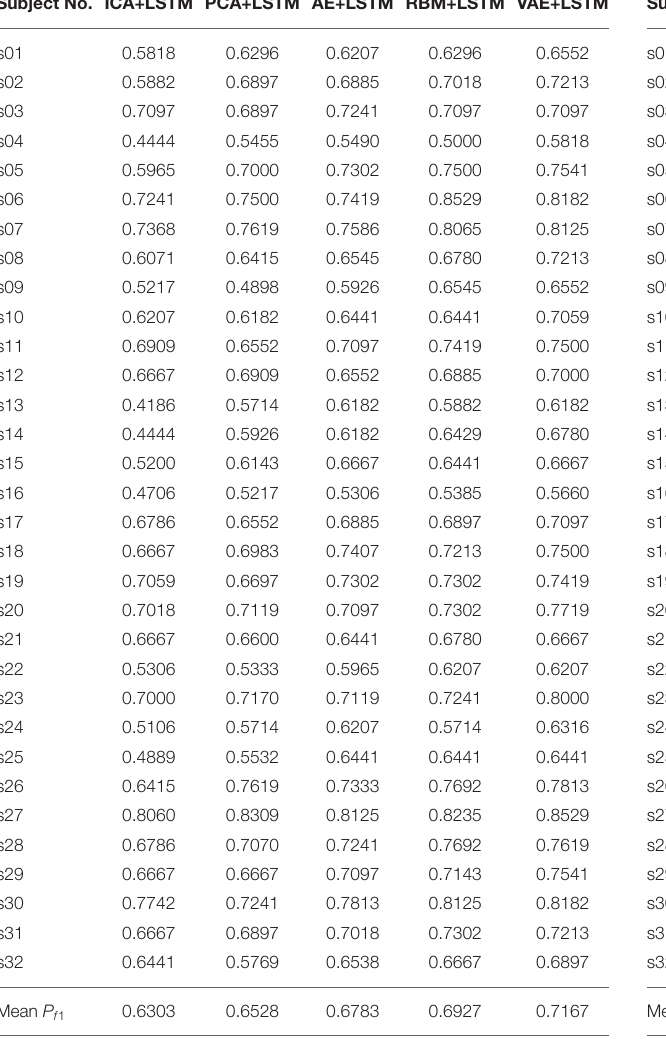
TABLE 2 | Recognition performance on subject data of DEAP dataset (Valence). TABLE 3 | Recognition performance on subject data of DEAP dataset